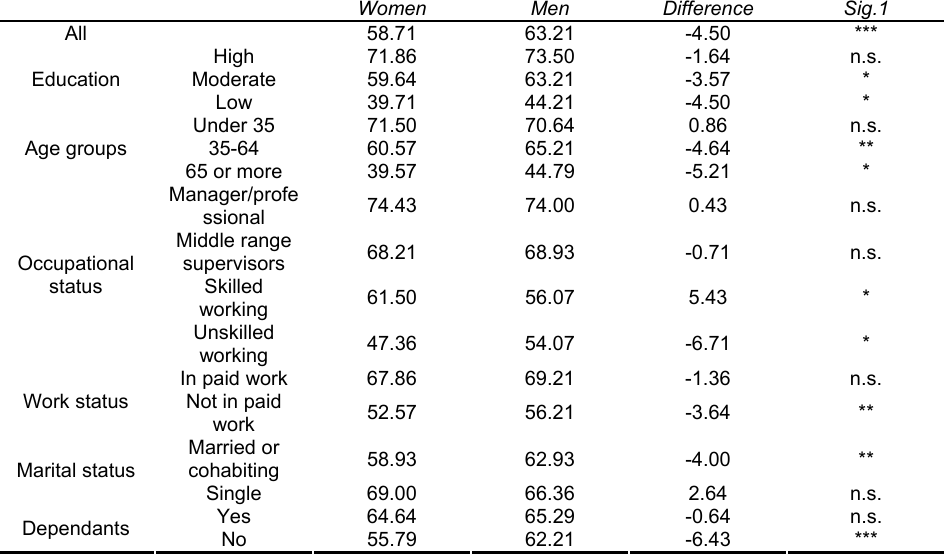
Table 4. Mean of network mobilization according to gender and control